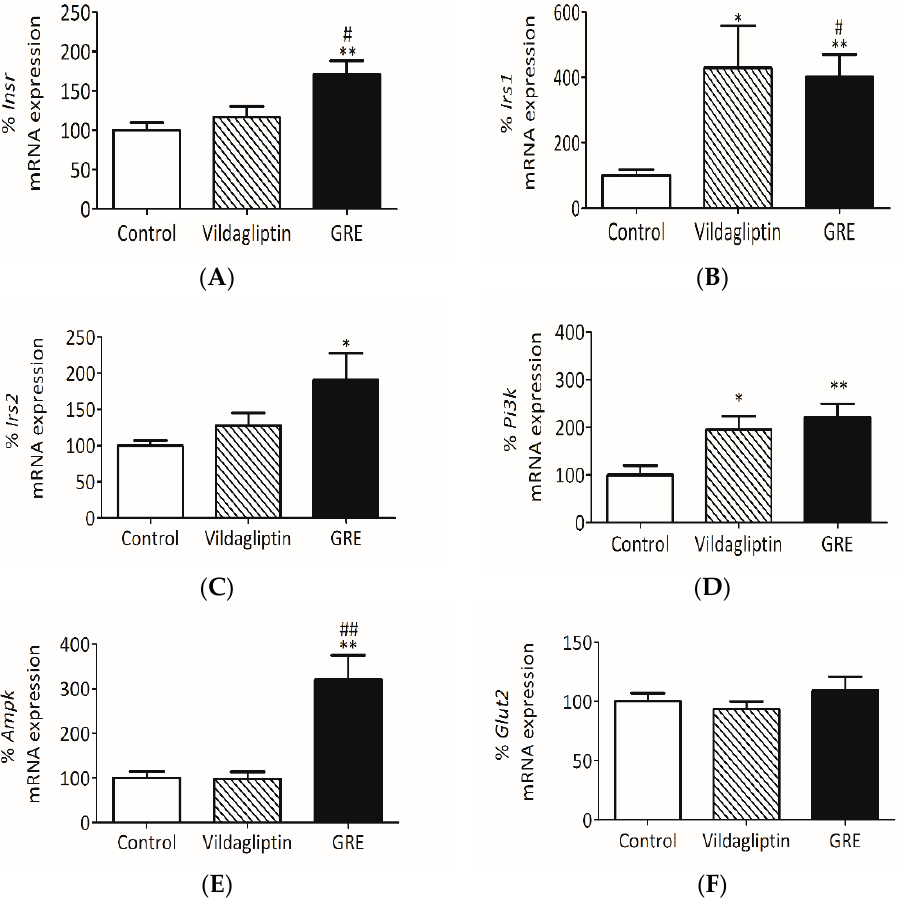
Figure 6. An aspalathin-enriched GRE improved insulin sensitivity by increasing insulin receptor ( Insr ) ( A ), insulin receptor substrate 1 ( Irs1 ) ( B ) , insulin receptor substrate 2 ( Irs2 ) ( C ) , phosphatidylinositol-4,5-bisphosphate 3-kinase Pi3k ( D ) , AMP-activated protein kinase Ampk ( E ), and glucose transported 2 ( Glut2 ) ( F ) in an obese insulin resistant (OBIR) Wistar rat model. OBIR rats were treated with GRE (195 mg/kg) or vildagliptin (10 mg/kg) for 12 weeks. Total RNA was extracted from liver tissue and gene expression studies were performed by RT-PCR. Data are reported as mean ± SEM of OBIR rats ( n = 6). * p ≤ 0.05, ** p ≤ 0.01 versus respective control; # p ≤ 0.05, ## p ≤ 0.01 versus vildagliptin control.